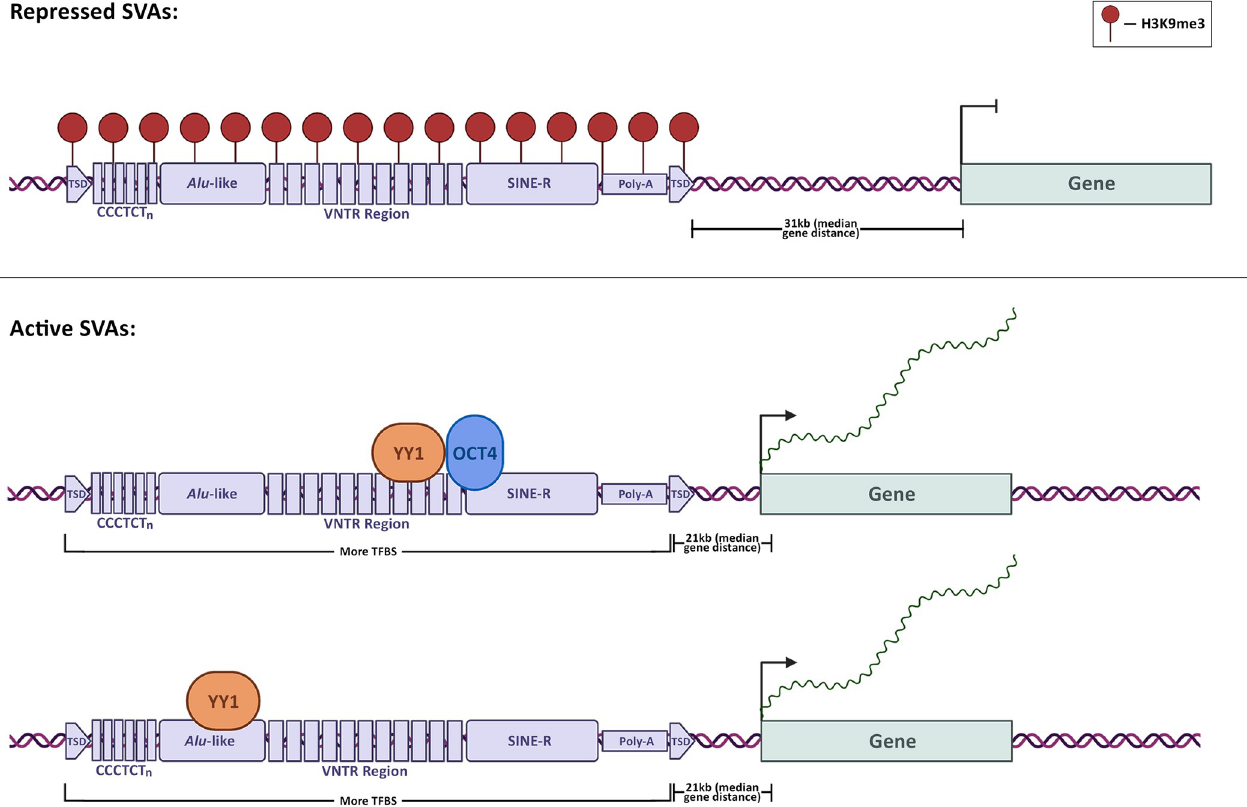
Fig 6. Model for SVA co-option in human pluripotent stem cell gene regulation. This figure was created with BioRender.com.